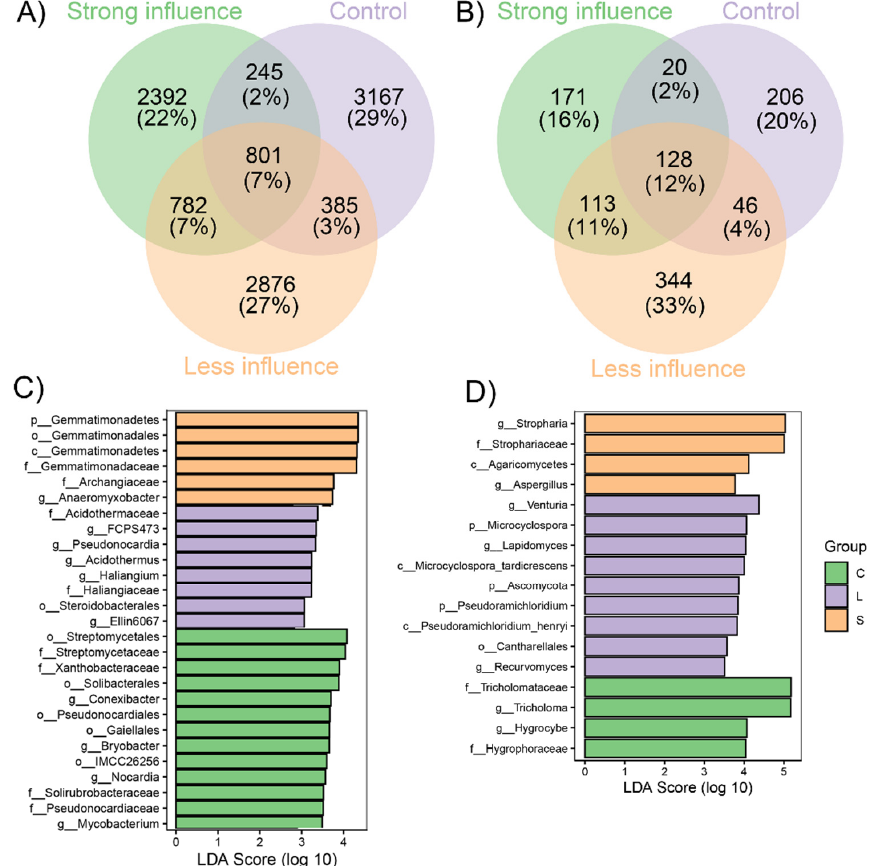
Figure 5. Core and unique bacterial ( A ) and fungal ( B ) OTUs in three different Stropharia rugosoan- nulata cultivation areas with various influencing intensities; and linear discriminant analysis (LDA) value distribution histogram of ( C ) bacteria and ( D ) fungal taxa. For C and D, p = phylum, c = class, o = order, f = family and g = genus.